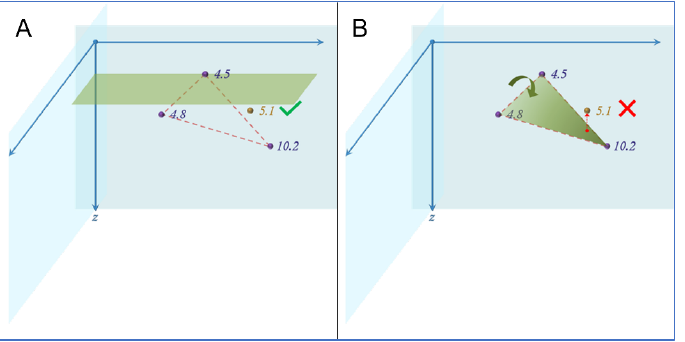
Figure 14. Example of the application of the Shoalest Depth testing method (i.e., the traditional flat triangle test ) ( A ) and the Tilted Triangle testing method ( B ). The 5.1-m survey soundings (in dark yellow) are only flagged by the Tilted Triangle testing method when compared to the chart soundings (in purple).